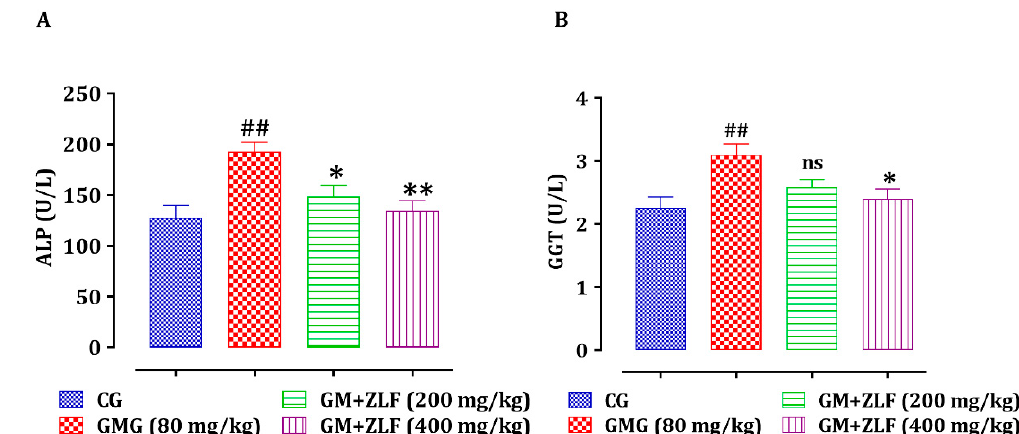
Figure 7. Effect of ZLF’s on serum alkaline phosphatase (A) and gamma-GT (B) in GM-poisoned rats. The data are displayed as mean ± SEM, ( n = 6). ## p < 0.01 related to CG. * p < 0.05, ** p < 0.01 related to the GMG. ns: not significant versus GMG. GM: gentamicin; CG: Control Group; GMG: GM treated Group.